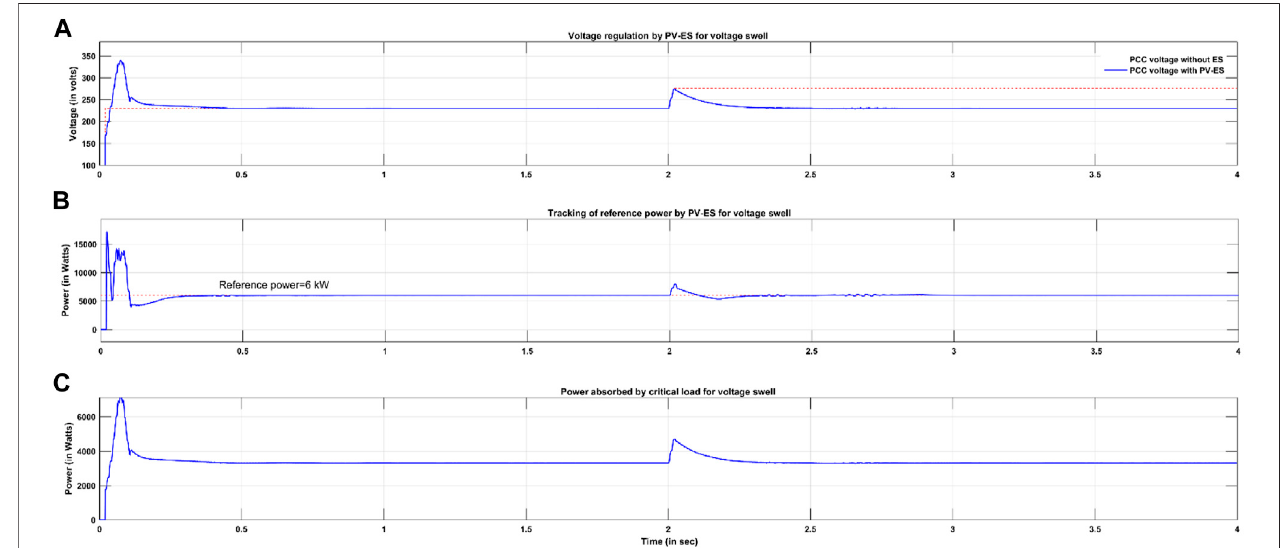
FIGURE 7 | PV-ES for voltage